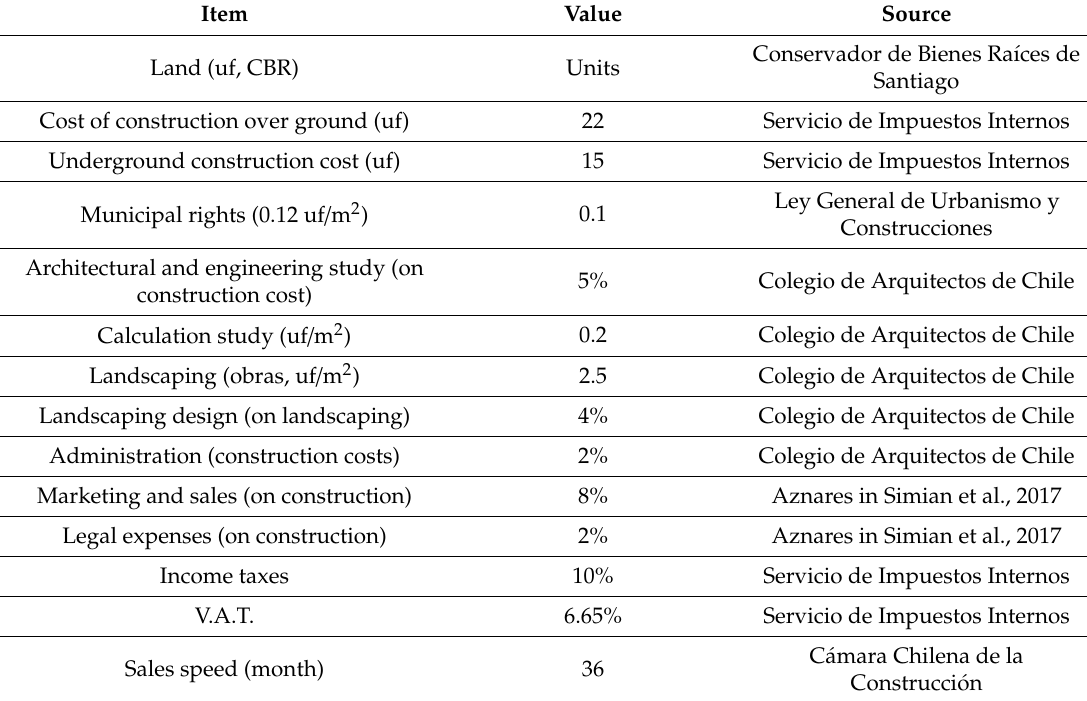
Table A3. Project cost structure. Source: